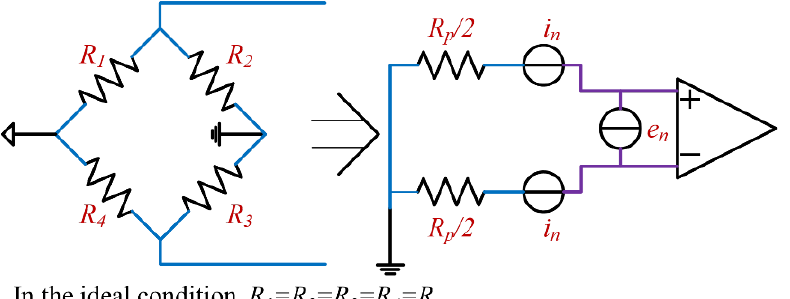
Figure 4. Equivalent noise source circuit. In the ideal condition, the resistance is equal and is R p . The four resistors of the Wheatstone bridge are equivalent to two resistors of value R p /2 at both ends of the amplifier.